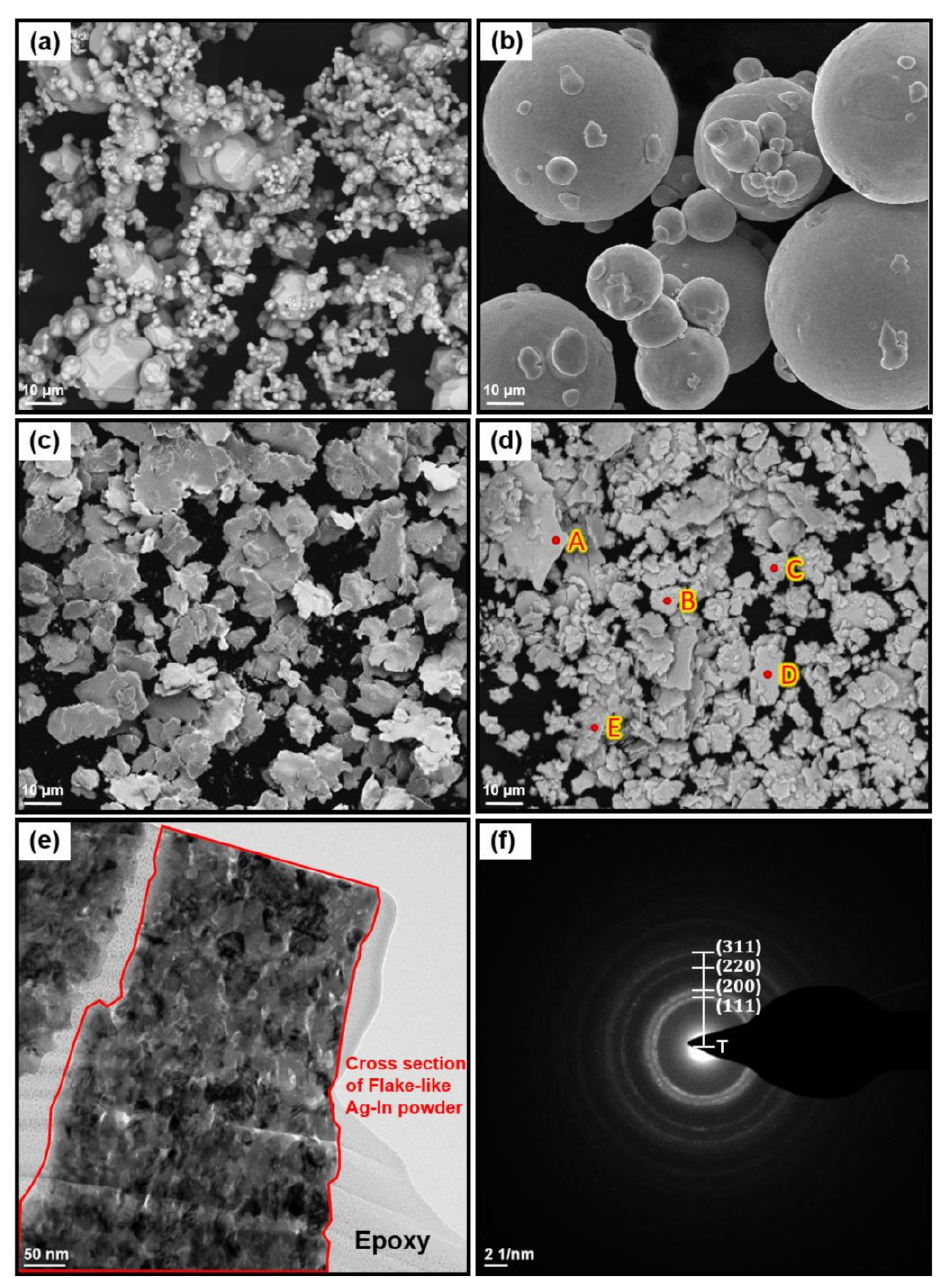
Figure 5. Raw and ball-milled powder characterizations. SEM images of ( a ) the raw Ag powder, ( b ) the raw In powder, ( c ) the ball-milled Ag powder, and ( d ) the ball-milled Ag–In alloy powder. ( e ) TEM images and ( f ) the corresponding TEM diffraction pattern for the ball-milled Ag–In alloy powder. The particle size distributions (PSDs) for the Ag and Ag–In alloy powders after the ball-milling process are shown in Figure 7. In the PSD analysis, the value D 50 indicates that 50 vol.% of the powder had a diameter less than this value. Herein, we regarded D 50